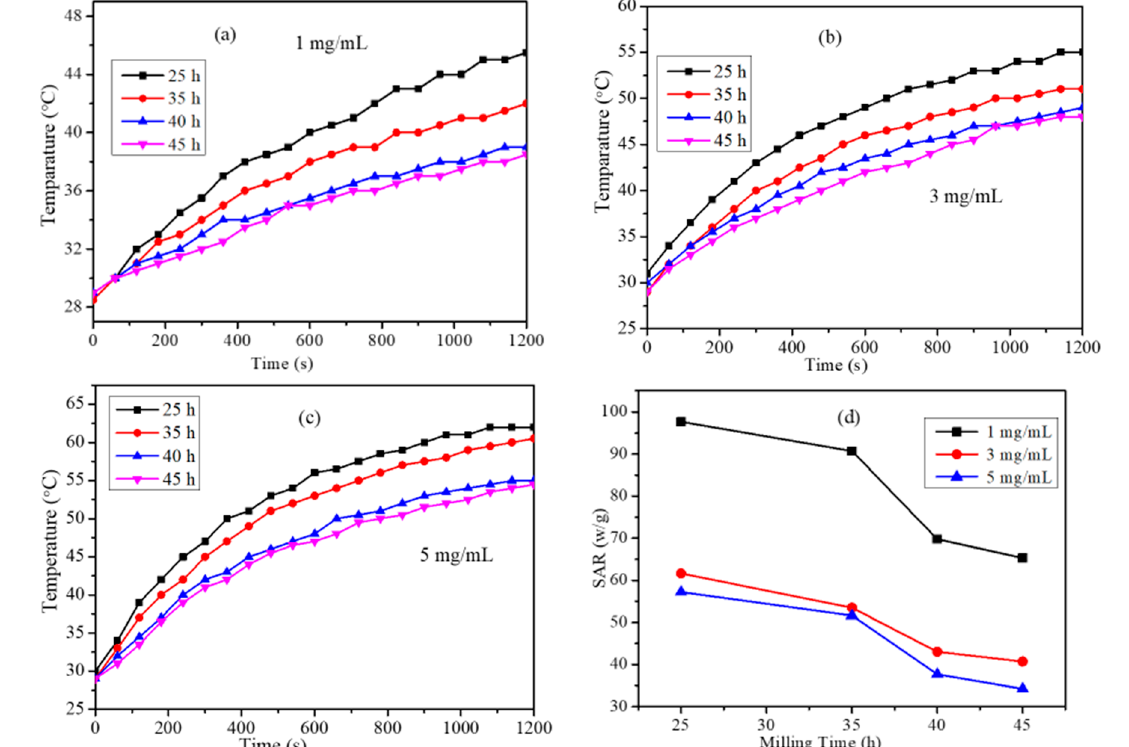
Figure 5. ( a , b , c ) Temperature vs. time for GO-Fe nanocomposite with a 50:50 (GO: Fe)